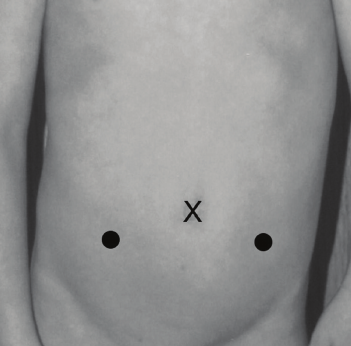
Figure 1: Port placement, bilateral reimplants. X = camera port, black dots = working ports.